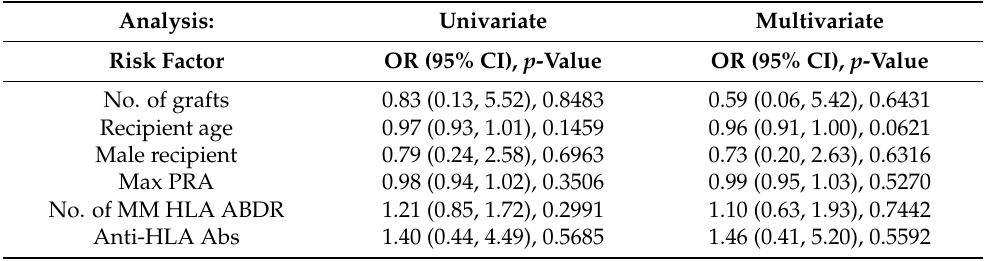
Table 2. Risk factors for ETA receptor expression (in univariate and multivariate analysis).